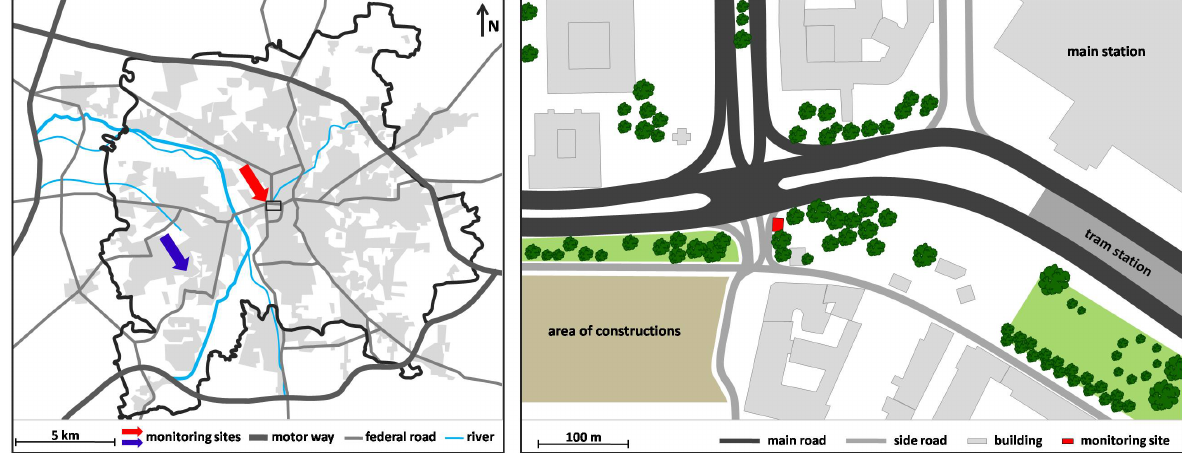
Fig. 1. Regional map of Leipzig, Germany, including the detailed surroundings of the LfULG monitoring site Leipzig-Mitte.